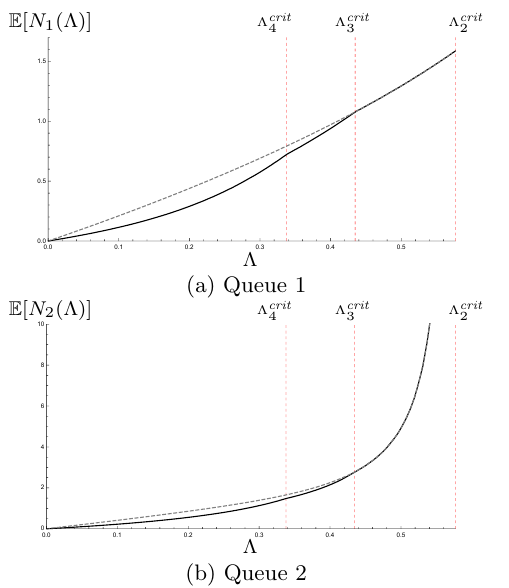
Figure 5: Simulated mean queue lengths for queues 1 and 2 in the original model (solid lines) and in the “corresponding” polling model (dashed